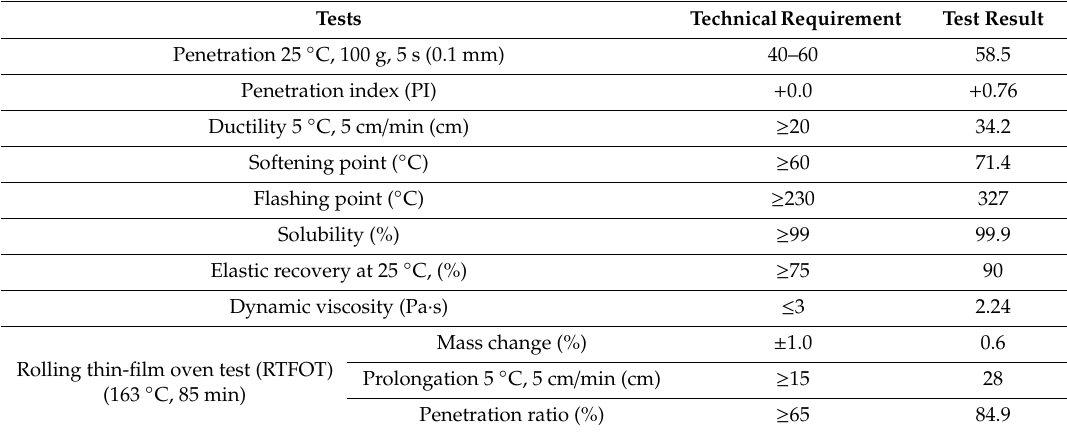
Table 3. Technical indexes of modified emulsified asphalt.